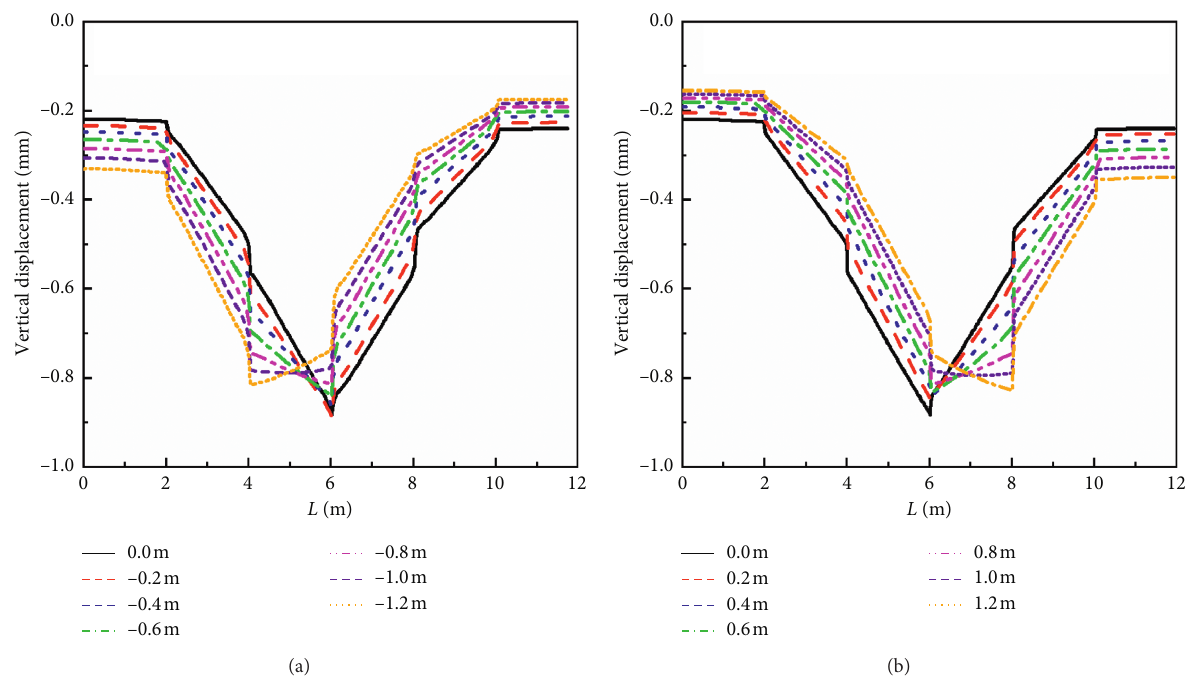
Figure 28: Longitudinal vertical displacement of the crown with different load positions: (a) above spigot and (b) above bell.